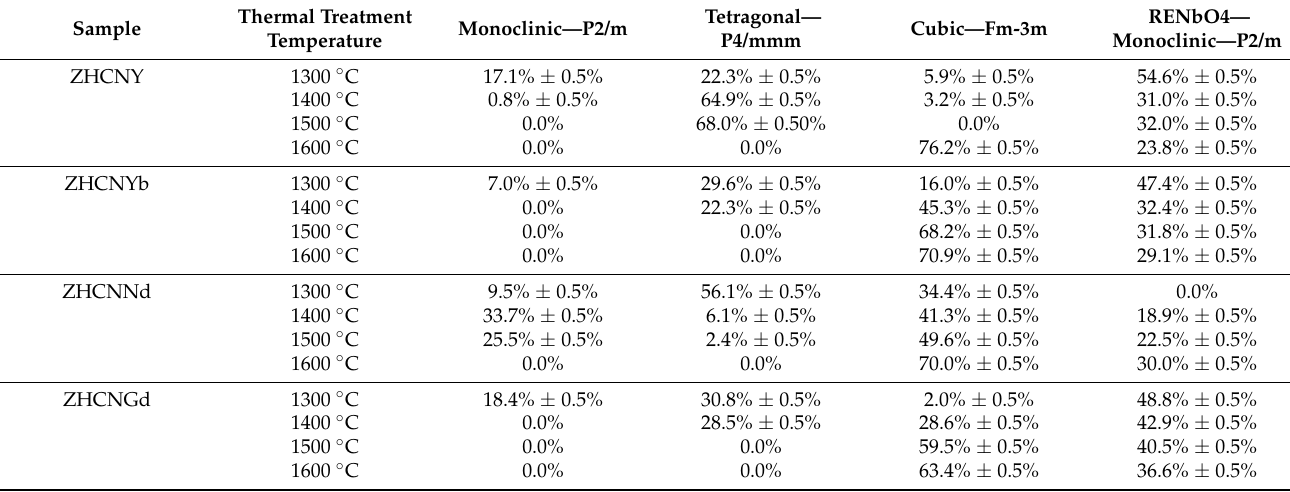
Table 2. Phase content for samples treated at 1300, 1400, 1500 and 1600 ◦ C belonging to equimolar ZrO 2 -HfO 2 -CeO 2 -Nb 2 O 5 - RE 2 O 3 systems (RE = Y, Yb, Nd,